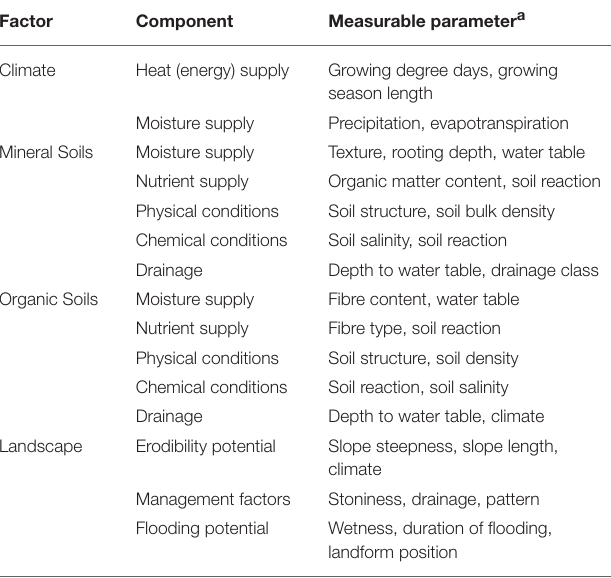
TABLE 2 | The factors, components and parameters used by LSRS to assess land